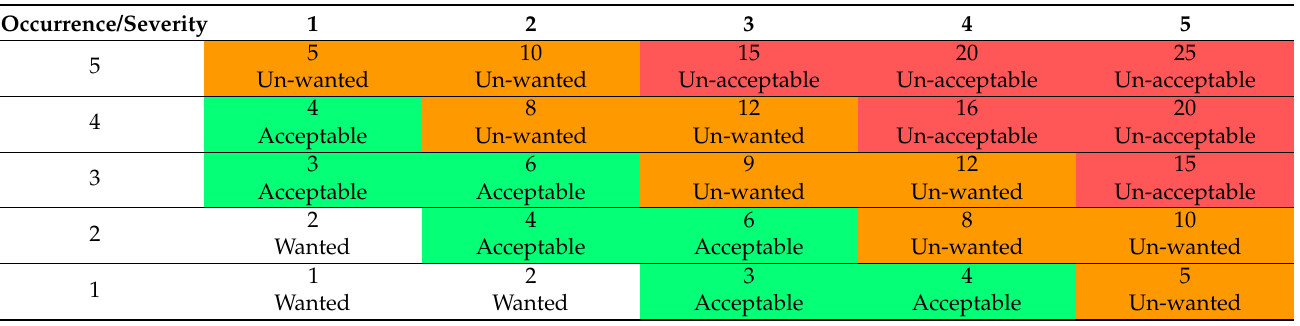
Table 2. Matrix frequency and